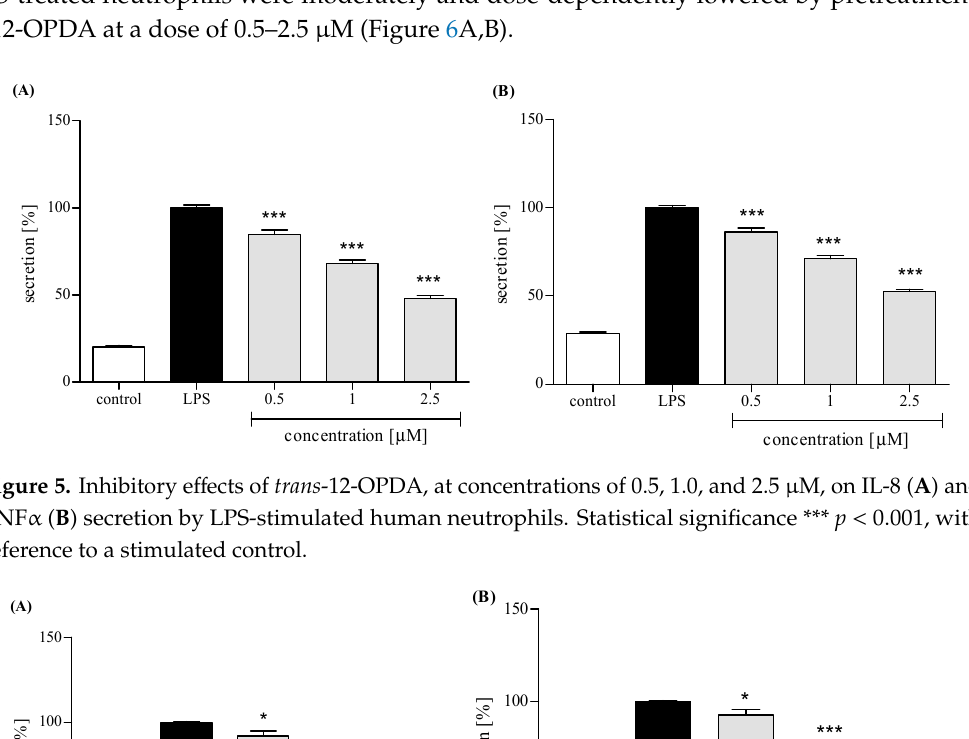
Figure 4. Inhibitory effects of trans -12-OPDA, at concentrations of 0.5, 1.0, and 2.5 μ M, on reactive oxygen species (ROS) release from f-MLP-stimulated human neutrophils. Statistical significance *** p < 0.001, with reference to a stimulated control.